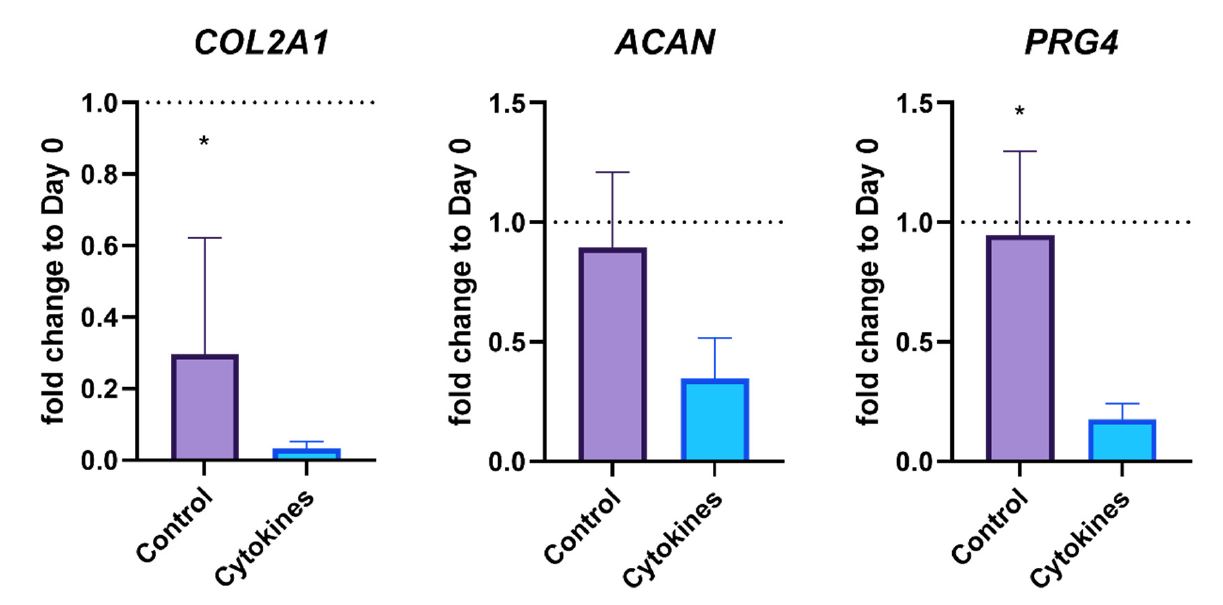
Figure 3. Expression of cartilage-specific genes after three days with and without Il-1ß/IL-17 treat- ment. The single asterisk indicates p < 0.05. The dotted lines represent the initial gene expression on day 0.